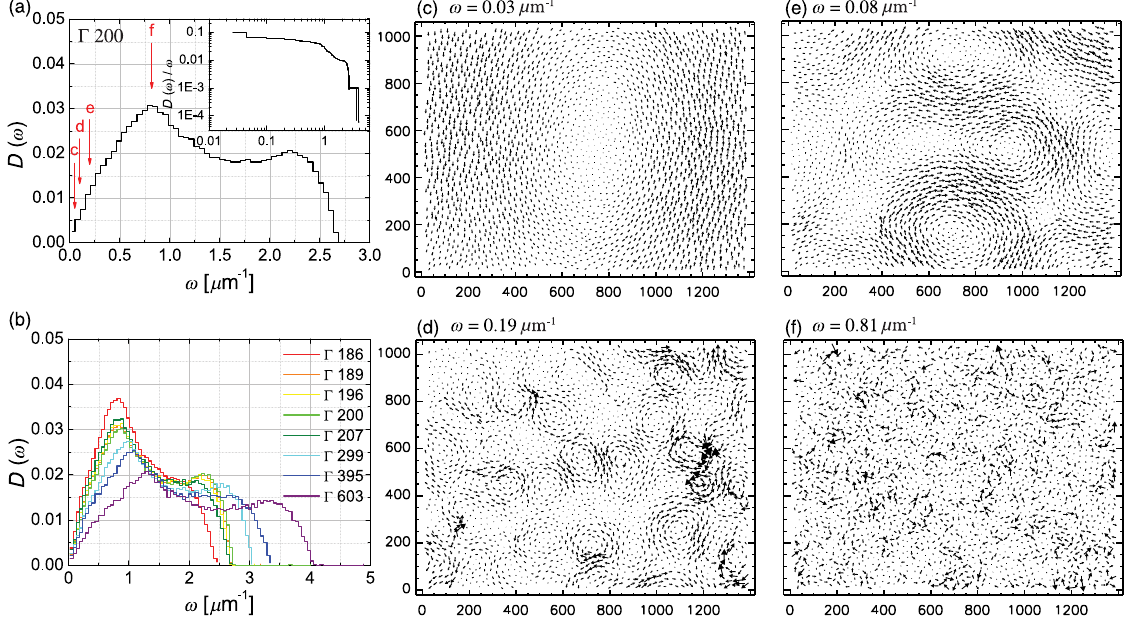
FIG. 6. (a) The spectrum of eigenvalues of the displacement field covariance matrix of big particles. By scaling with ω , the inset reveals convincing Debye behavior. (b) shows D ð ω Þ for various inverse temperatures. The red arrows in (a) labeled c – f indicate positions in the spectrum where the mode structure is shown in panels (c) – (f) for Γ ¼ 200 . The corresponding “ frequencies ” are given above the respective graphs. For details, see the